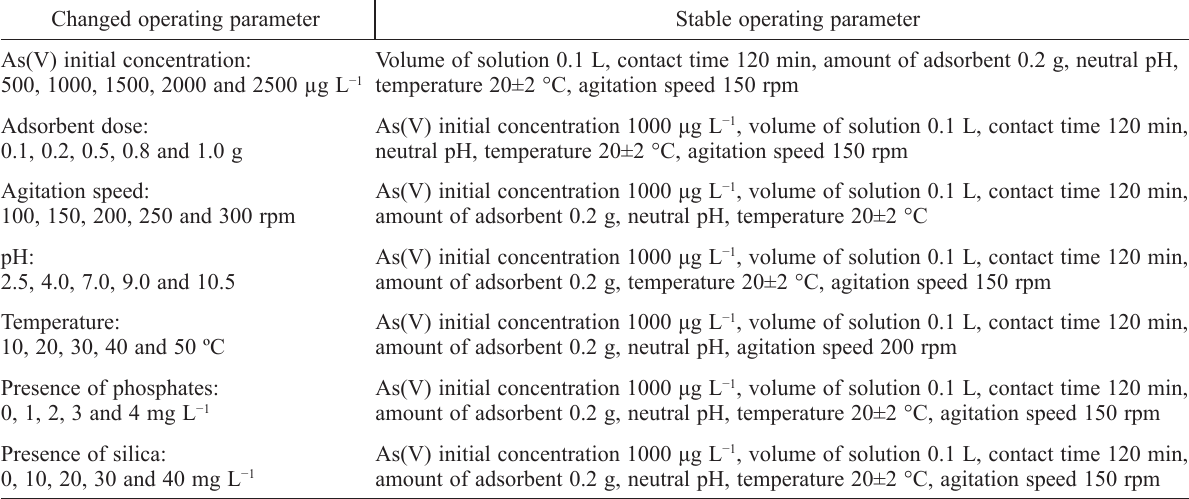
Table 2 – Experimental setup for study of the impact of different operating conditions Changed operating parameter Stable operating